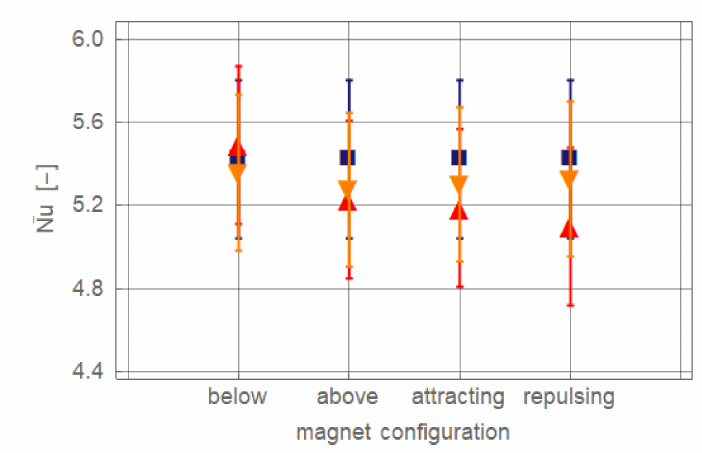
Figure 6. Comparison of averaged Nusselt number for different magnet configurations with Re in = 236.6 ± 3.5. Symbols indicate ferronanofluid without magnet (dark blue (cid:4) ) and with magnet(s), for r cl = 34 mm (red (cid:78) ), and for r cl = 55 mm (orange (cid:72)